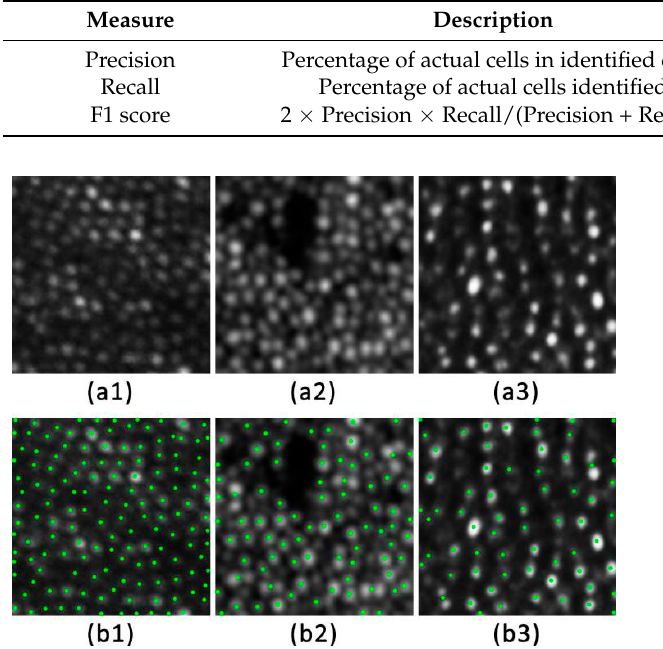
Figure 10. Cone cell identification using the proposed method. ( a ) Input AO-SLO images of healthy eye with low cone cell density ( 1 ), eye with diabetic retinopathy ( 2 ), and eye with acute zonal occult outer retinopathy ( 3 ). ( b ) Corresponding cone cell identification results.